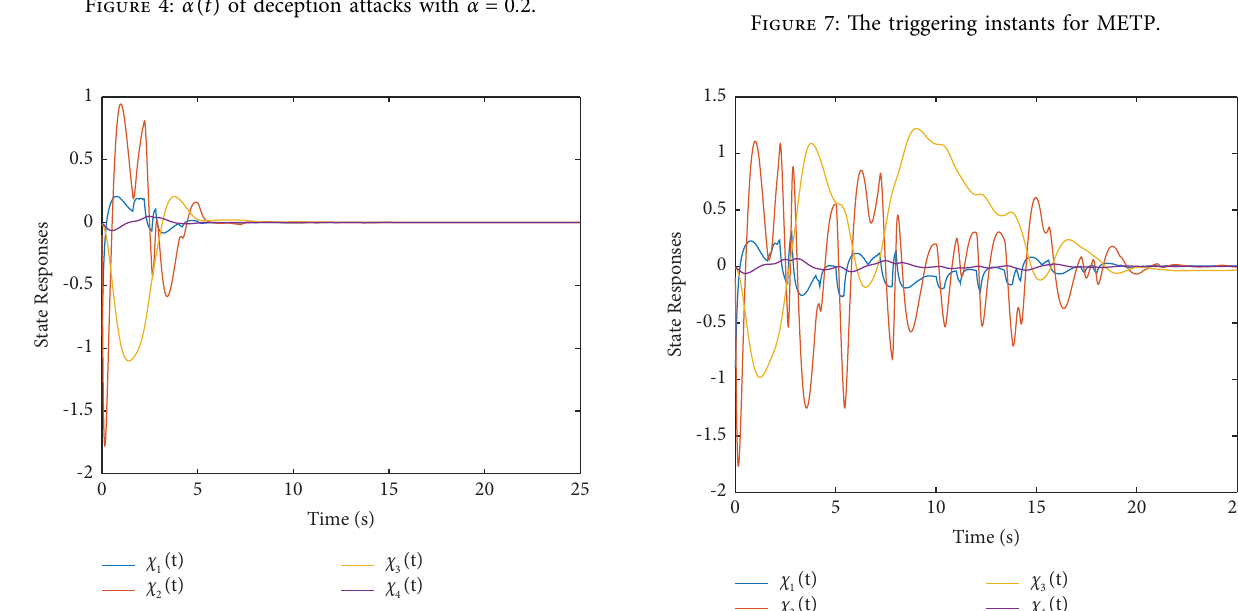
Figure 5: Te state trajectories χ ( t ) for MAETP.